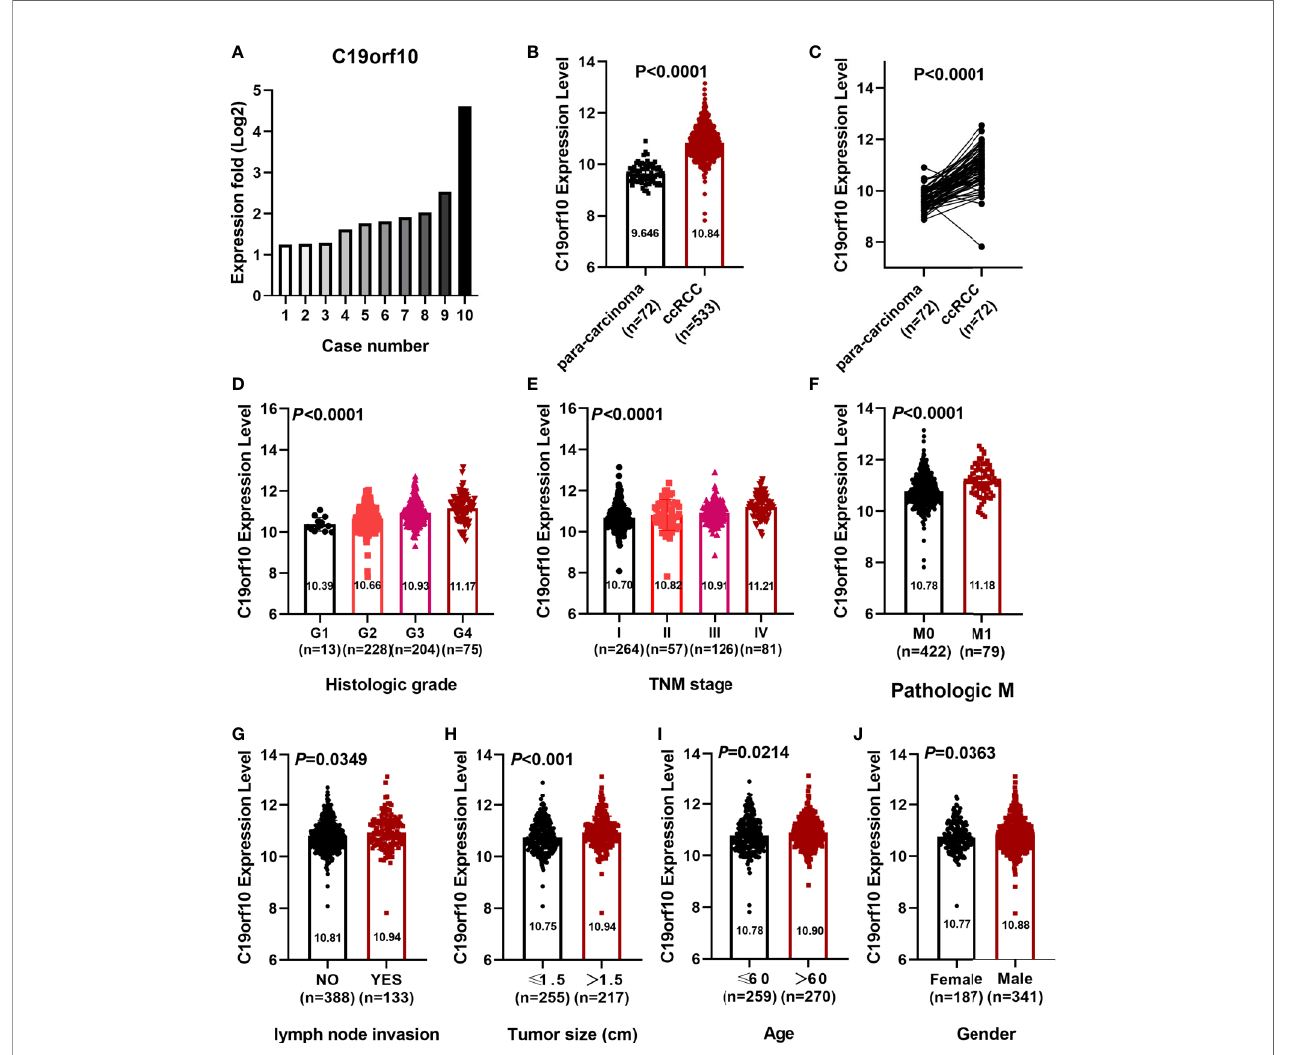
FIGURE 1 | C19orf10 expression elevated in KIRC and correlated with clinical characteristics. (A) C19orf10 expression in 10 paired KIRC samples. (B) C19orf10 expression in KIRC in TCGA dataset. (C) C19orf10 expression in 72 paired KIRC in TCGA dataset. (D – J) Relative mRNA expression level of C19orf10 in TCGA dataset with differential histologic grade (D) , TNM stage (E) , pathologic metastasis (F) , lymph node invasion (G) , tumor size (H) , age (I) and gender (J) . The numbers of samples are indicated in fi gures, Mean ± SD is shown. P values are calculated by Student ’ s t-test or one-way ANOVA and indicated in fi